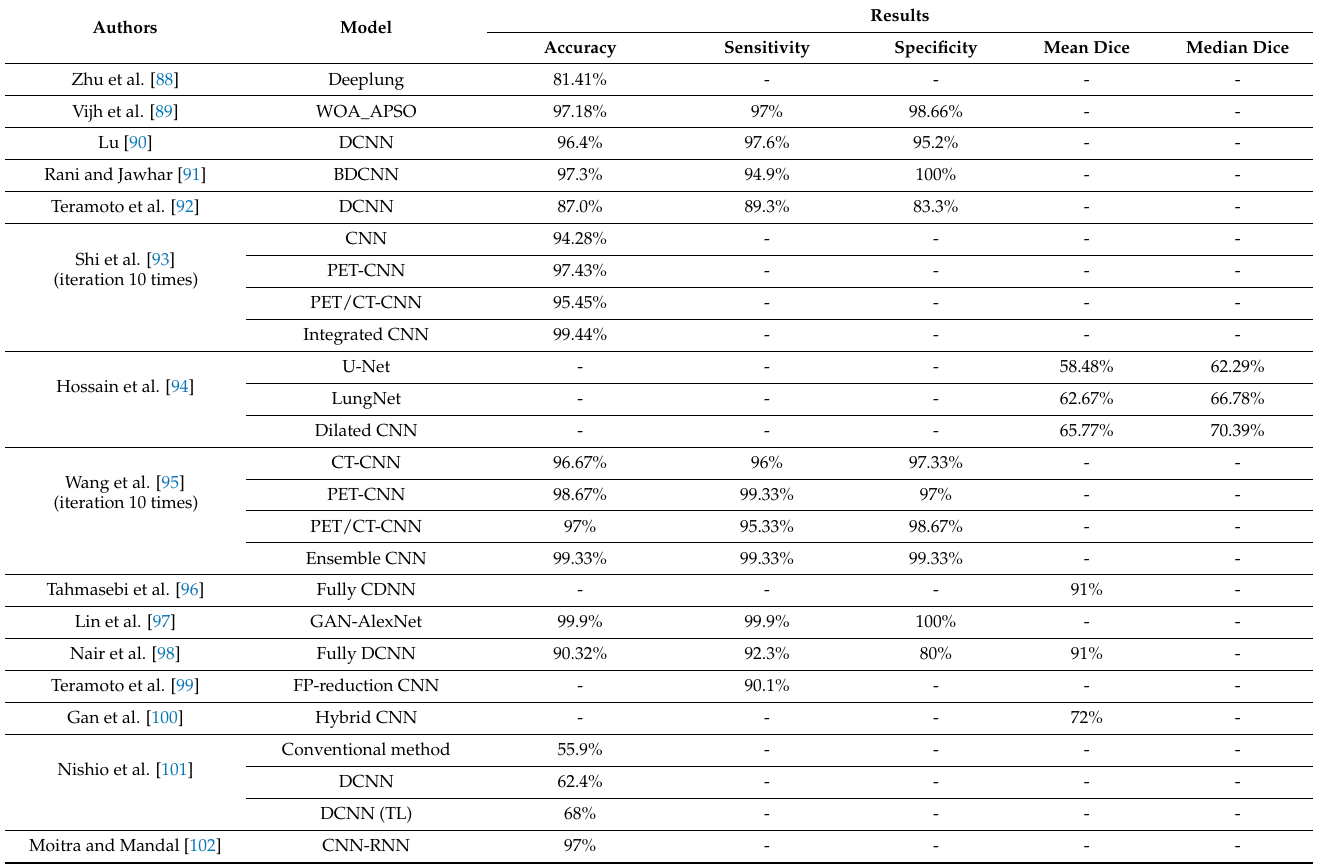
Table 4. Results of the application of convolutional neural networks in the lung tumor